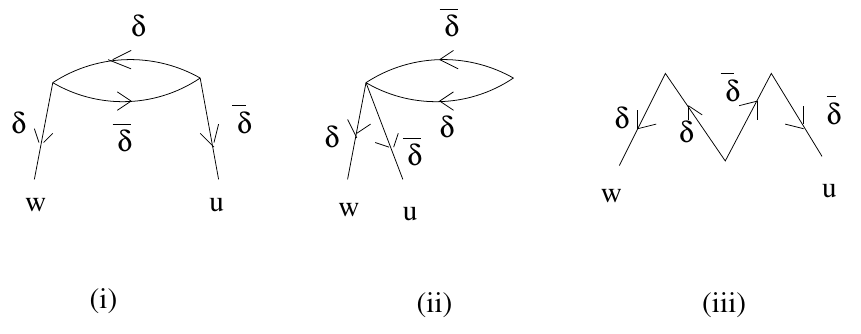
Figure 6 . Skeleton graphs for (i) (cid:8) 1 ;C , (ii) (cid:8) 1 ;D and (iii) (cid:8) 1 ;E .